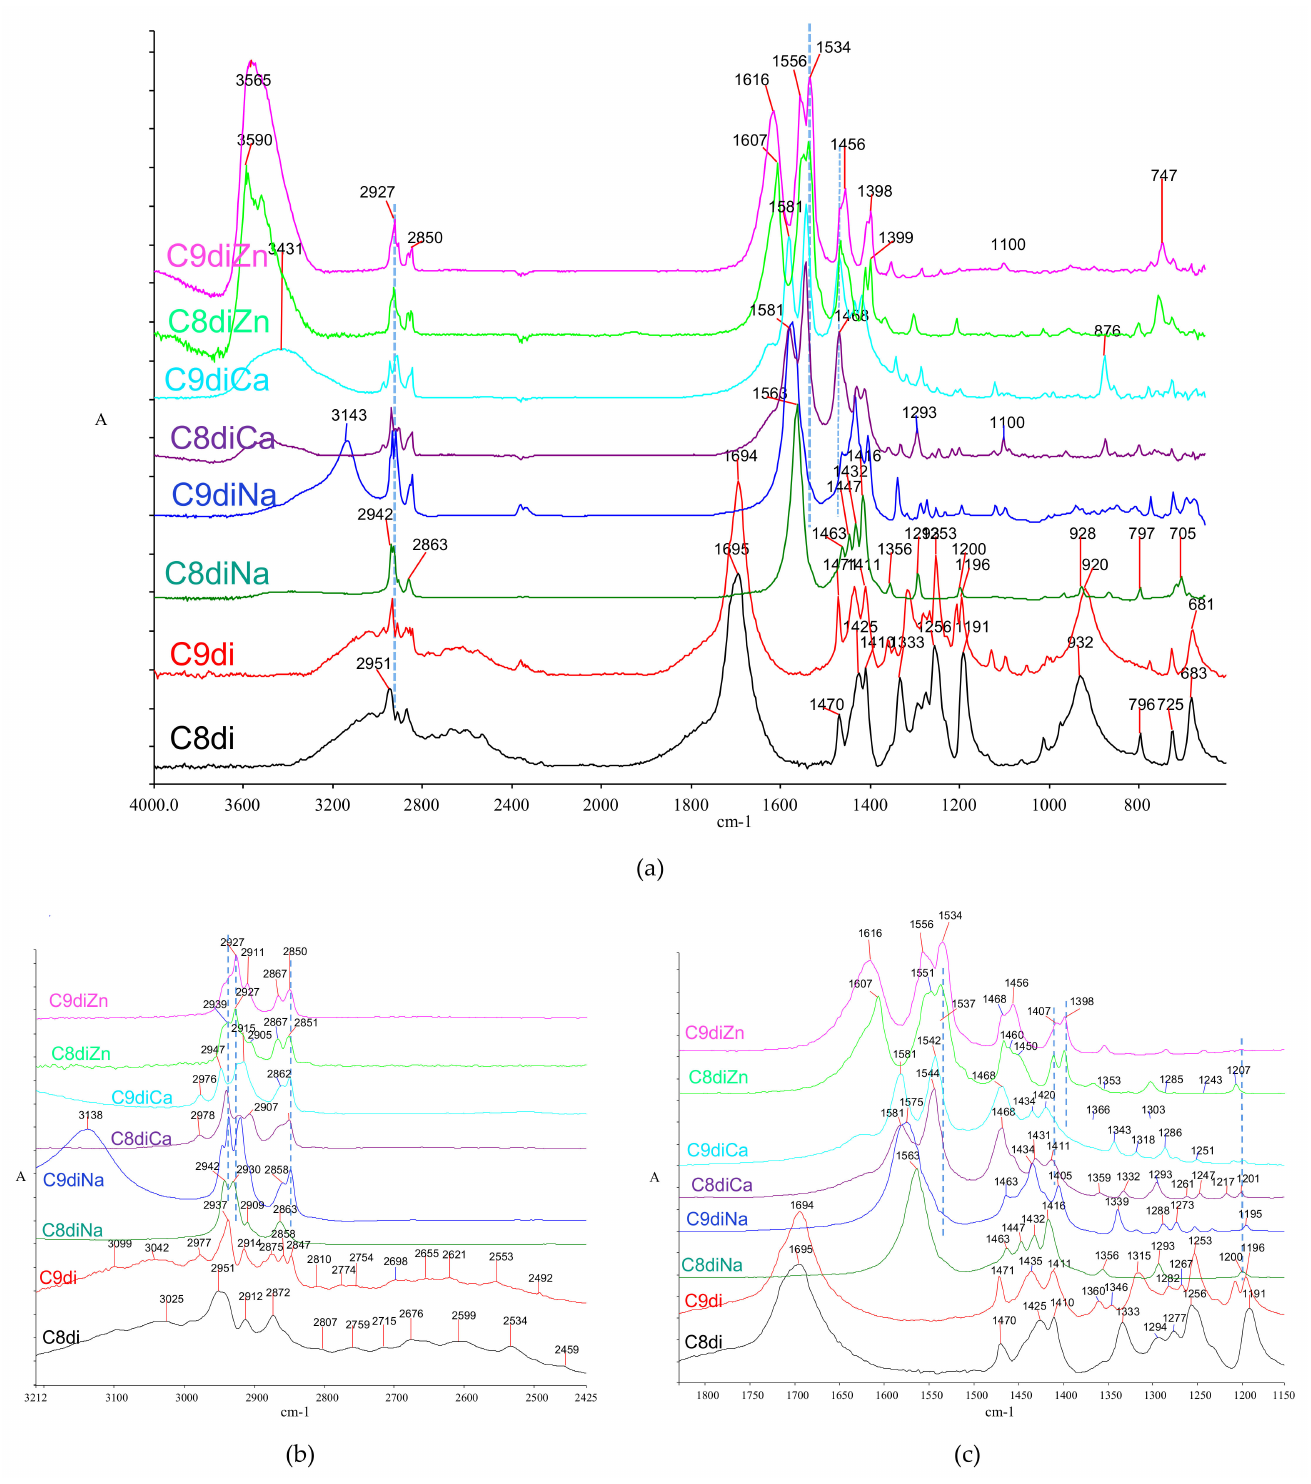
Figure 8. Infrared spectra of selected dicarboxylic acids and their sodium, calcium, and zinc salts. ( a ) Full spectrum; ( b ) C-H stretching region; and ( c ) 1800–1150 region. In all spectra: C8di, octanedioic acid (suberic acid); C9di, nonanedioic acid (azelaic acid); C8diNa, C8diCa, and C8diZn, sodium, calcium, and zinc octanedioates (suberates), respectively; C9diNa, C9diCa, and C9diZn, sodium, calcium, and zinc nonanedioates (azelates), respectively. Similar to monoacids, the hydroxyl stretching is typically observed as a broad band, spanning 3200–2800 cm − 1 . On the other hand, and in contrast to monoacids, the